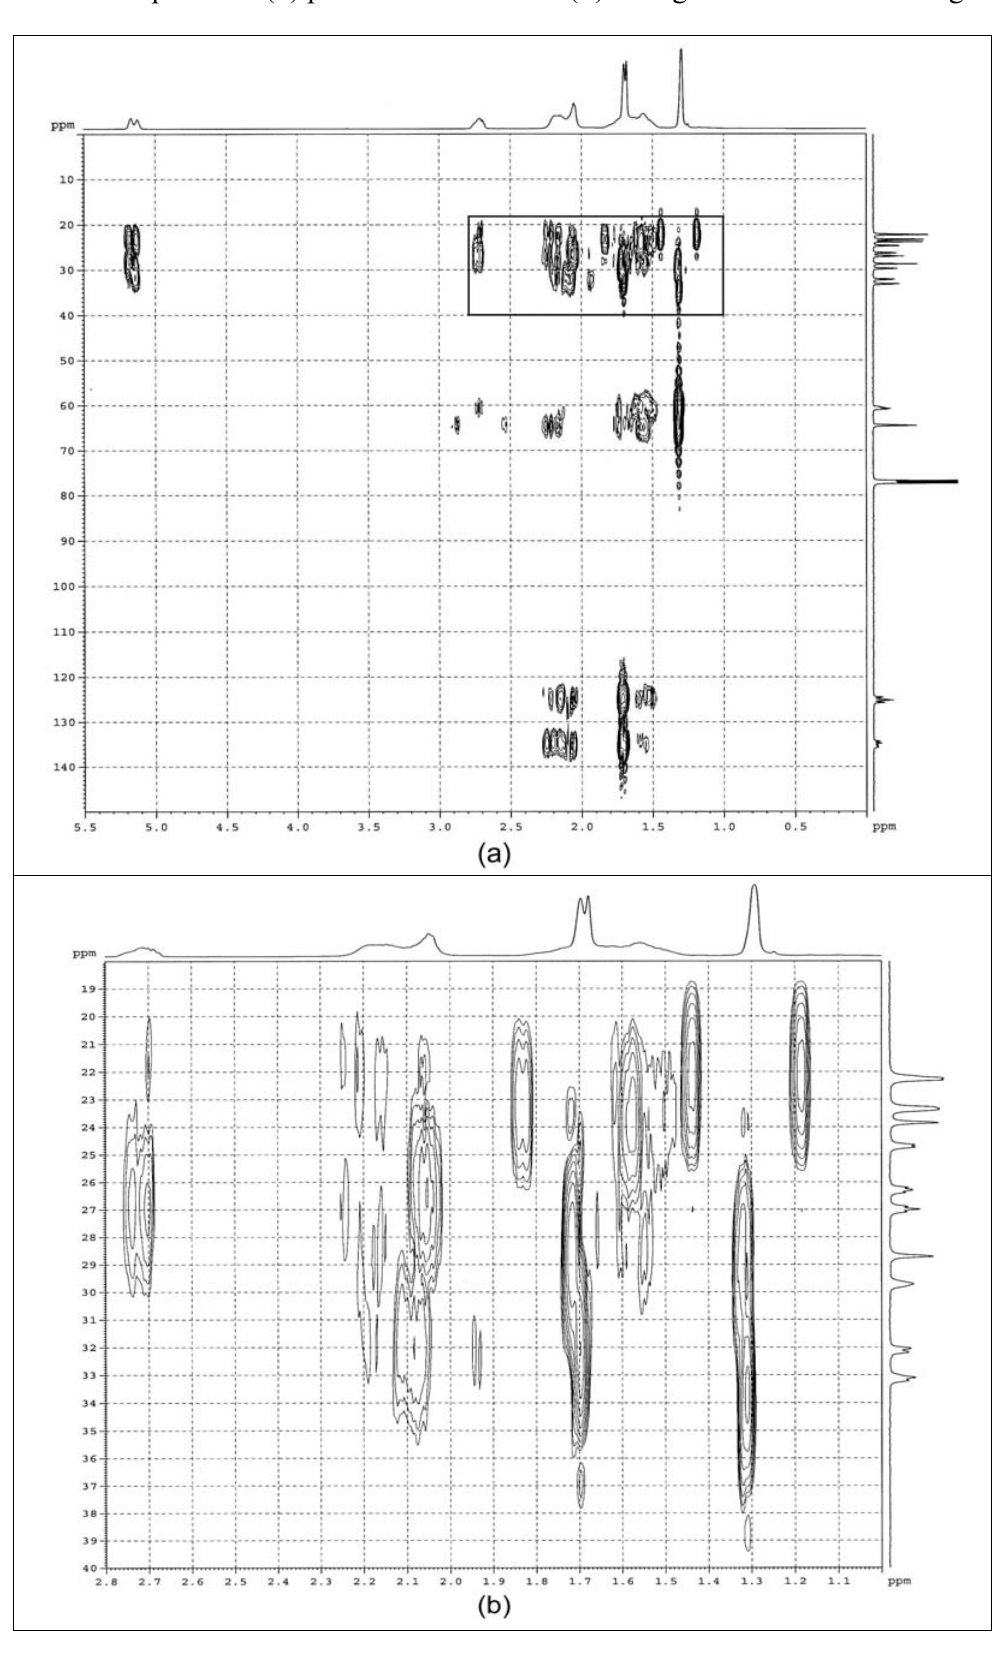
Figure 5. HMBC spectra of ( a ) purified ENR-50 and ( b ) enlargement of the boxed region in ( a